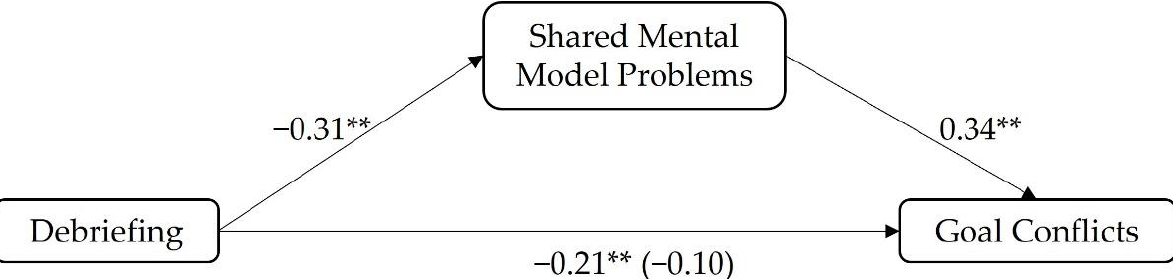
Figure 4. Results of Hypothesis 2c: * p < 0.05; ** p < 0.001.